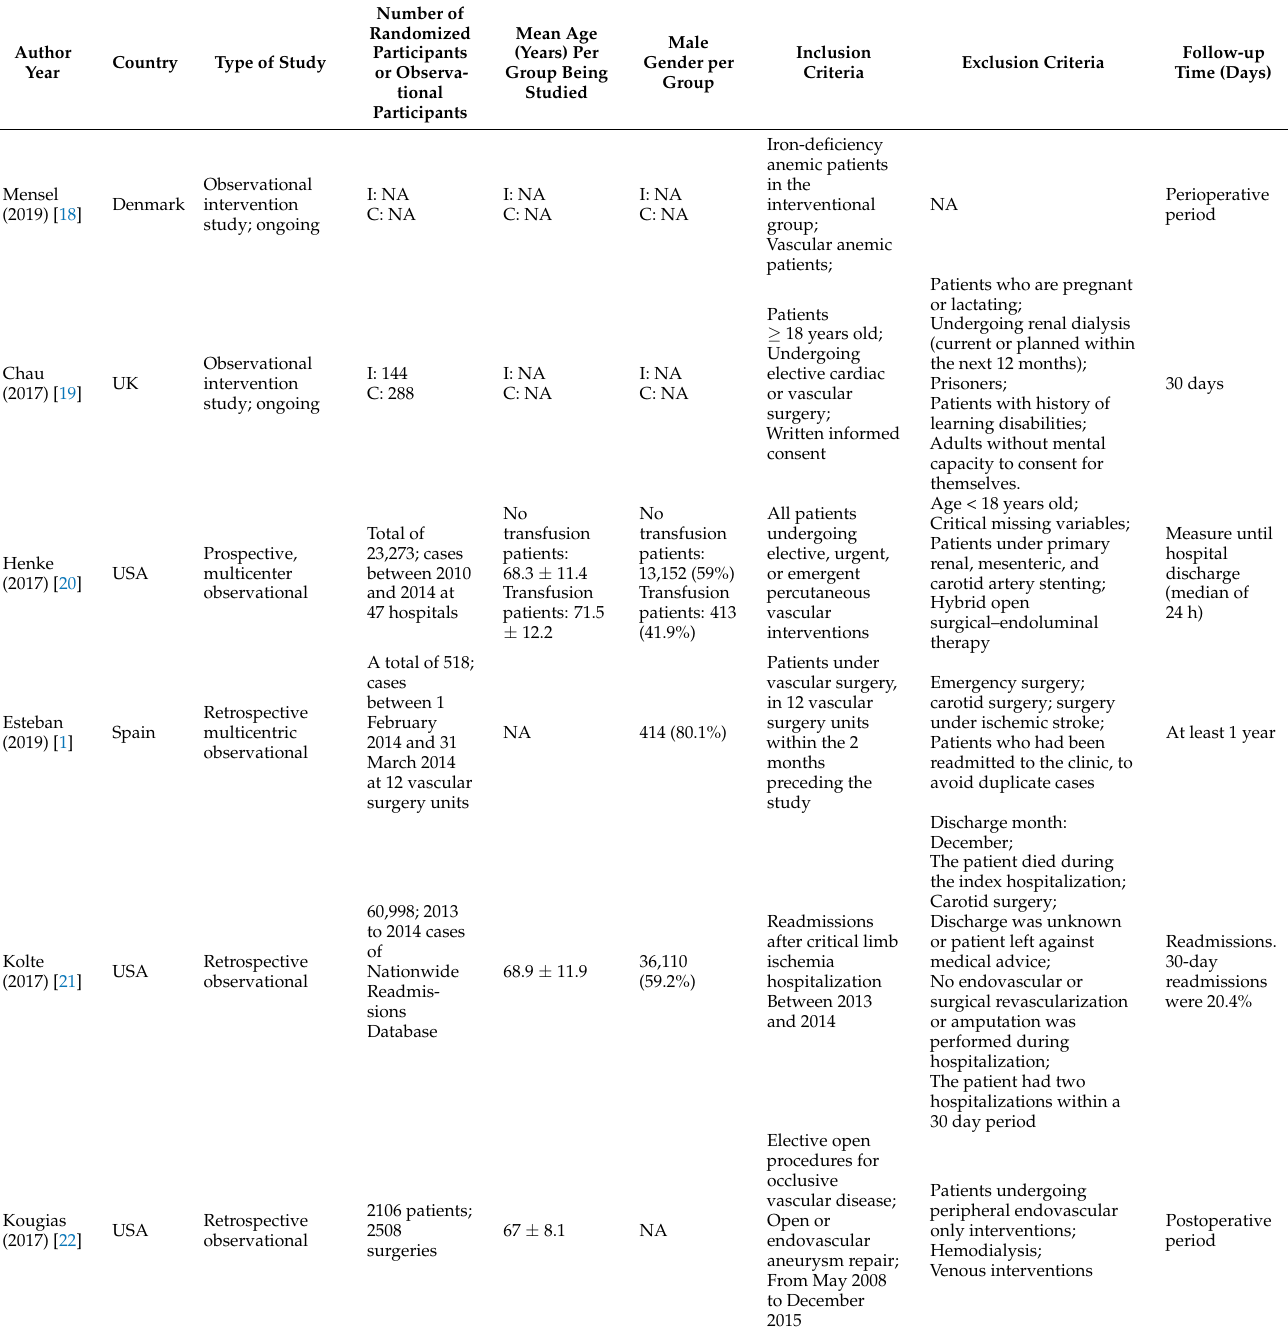
Table 1. Study characteristics related to